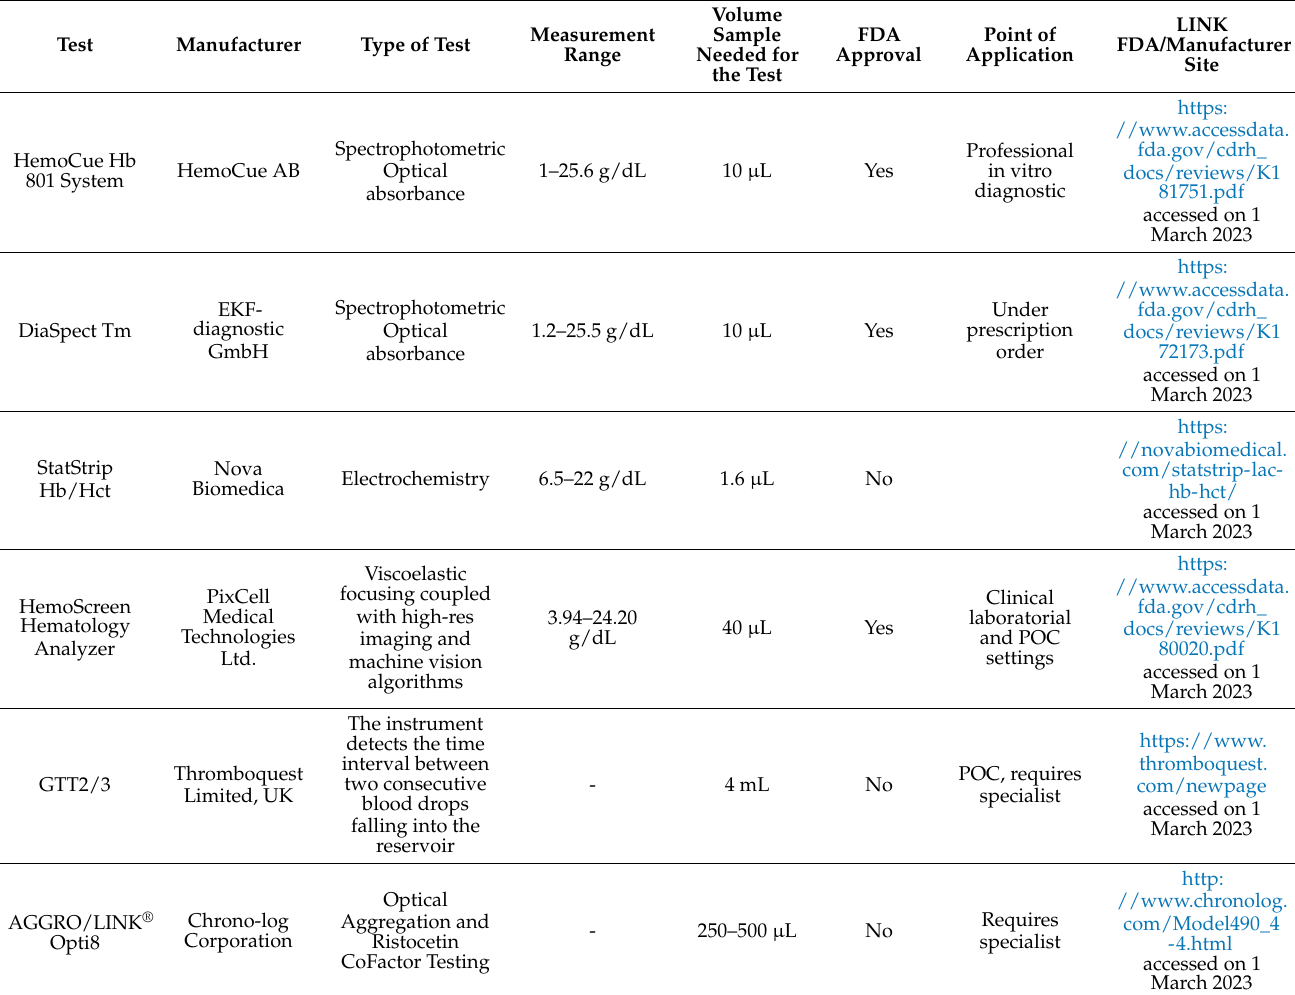
Table 1. On-the-market products for hemoglobin quantification in POC